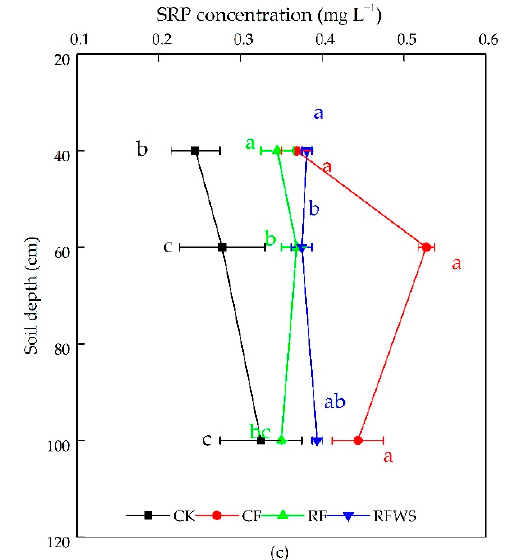
Figure 5. P concentration in leaching water on June 6: ( a ) TP concentration; ( b ) TDP concentration; and ( c ) SRP concentration. Different lowercase letters in the same soil layer in the figure indicate significant differences between treatments ( p < 0.05).